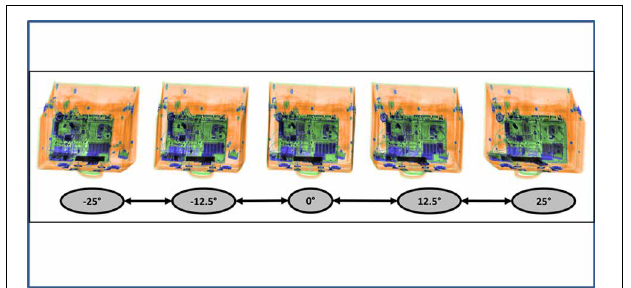
FIGURE 1 | Example of motion imaging X-ray images provided by the machine evaluated in this study. The image in the middle shows the initial image (0 ◦